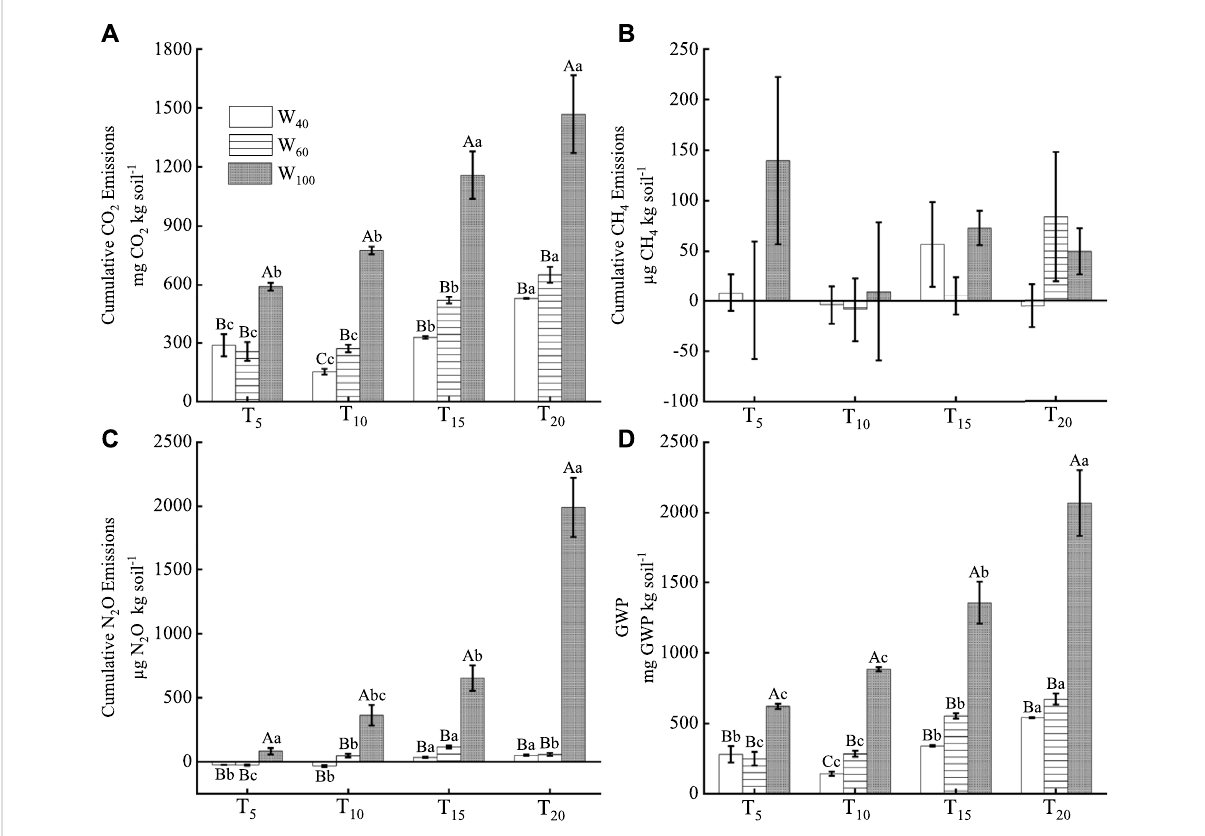
FIGURE 3 InteractionsoftemperatureandmoisturetreatmentonsoilcumulativeCO 2 ,CH 4 andN 2 Oemissionsattheendofculture.Thecapitallettersare the differences between the same temperature and different moisture treatments, and the lowercase letters are the differences between the same moisture and different temperature treatments. The error bars show standard errors: n = 3.